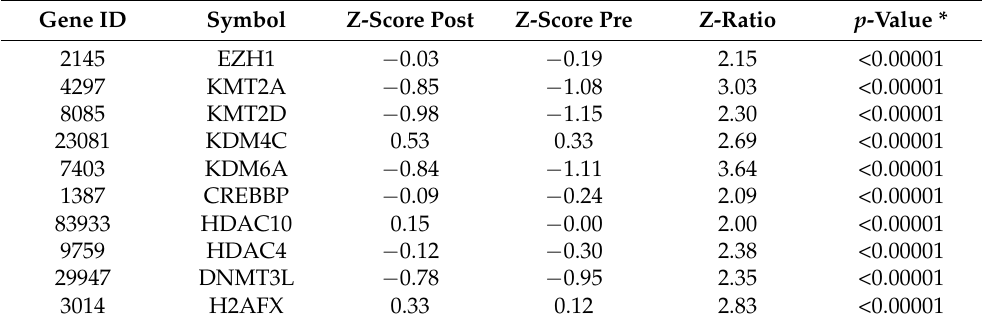
Table 1. Description and expression data of overexpressed genes associated with chromatin modifica- tions included in the present study.